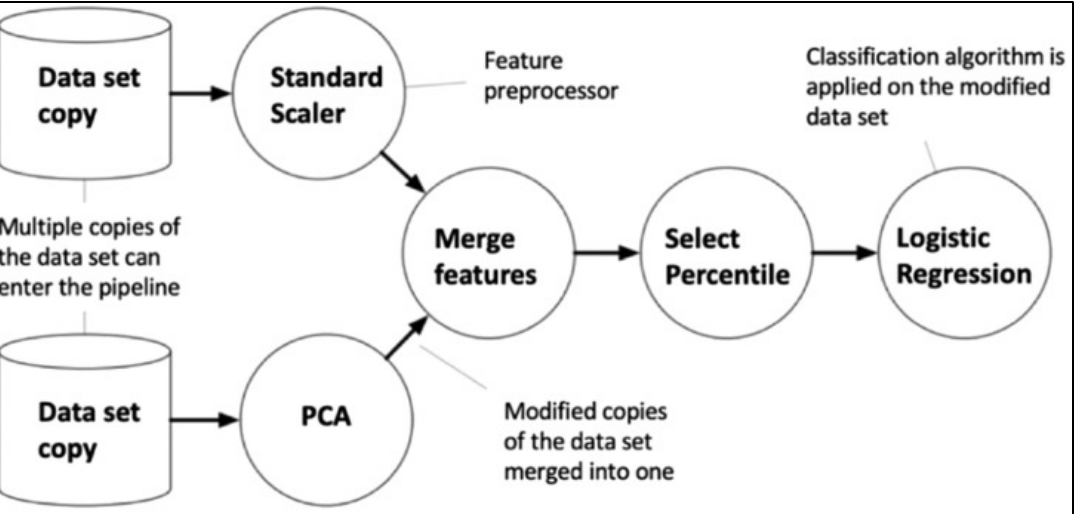
Figure 1. Tree-based pipeline from TPOT. Reprinted with permission from Ref. [37]. 2019, Oxford University Press.